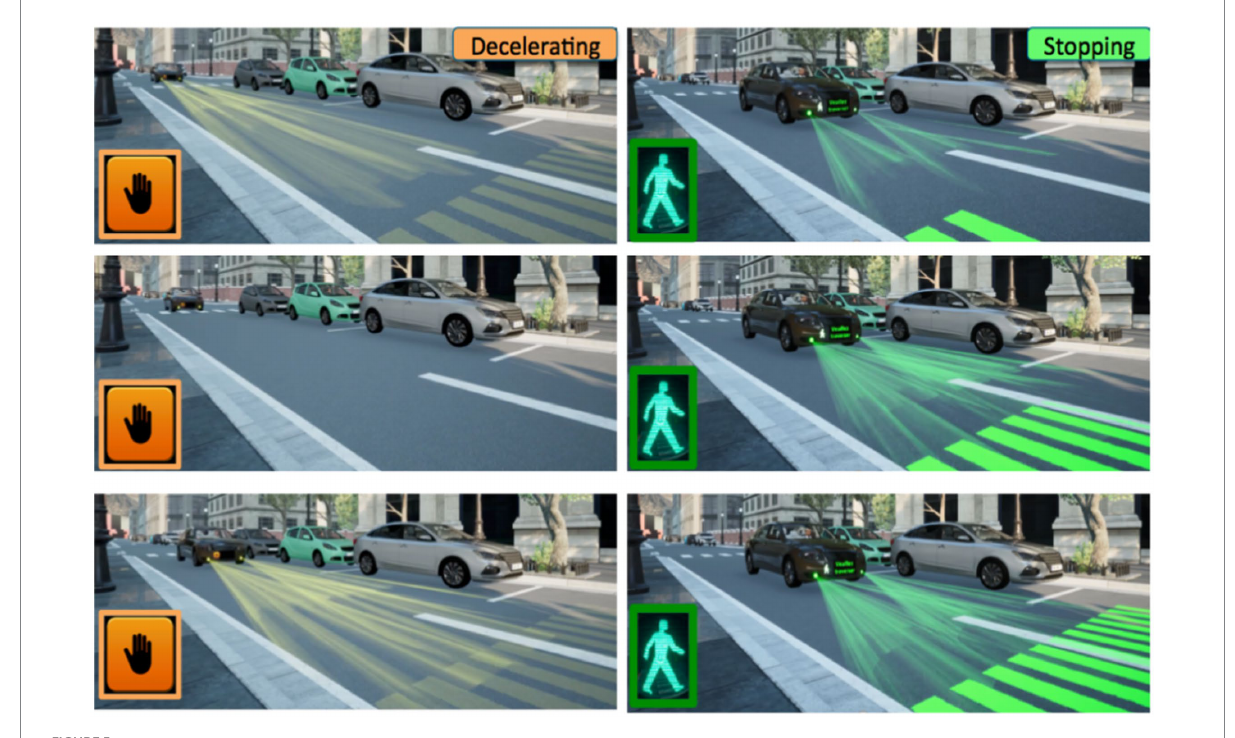
FIGURE 5 eHMI when the AV is decelerating (left sequence) and stops (right